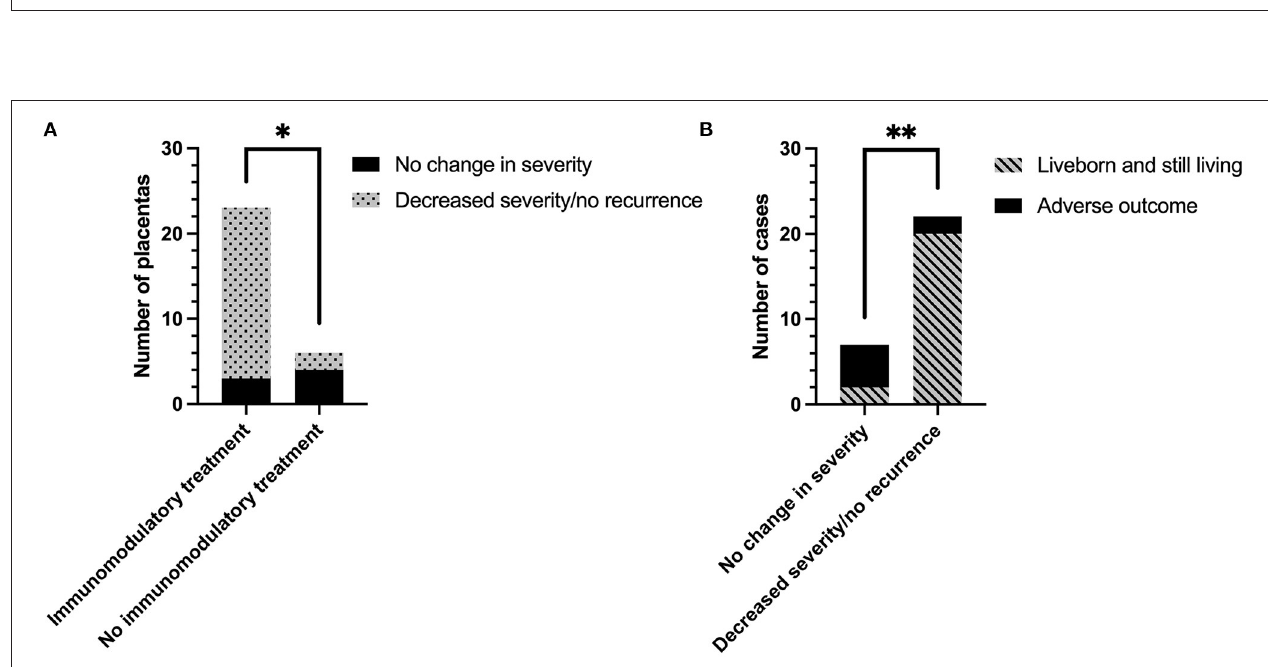
FIGURE 4 | The effect of immunomodulatory medication in subsequent pregnancies after a diagnosis of chronic histiocytic intervillositis (CHI). (A) Change in CHI lesion severity in pregnancies treated with or without immunomodulatory medication, compared to the participant’s first placenta diagnosed with CHI from a previous pregnancy. Severity of CHI was determined by pathologist’s report. Immunomodulatory treatment refers to a regimen including one or both of prednisolone and hydroxychloroquine in combination with either aspirin, heparin, or both. Pregnancies without immunomodulatory treatment were untreated or received aspirin or heparin or both. (B) Rate of infants liveborn and still living (past 28 days of life) in subsequent pregnancies related to change in CHI severity. * p < 0.05; ** p < 0.01.